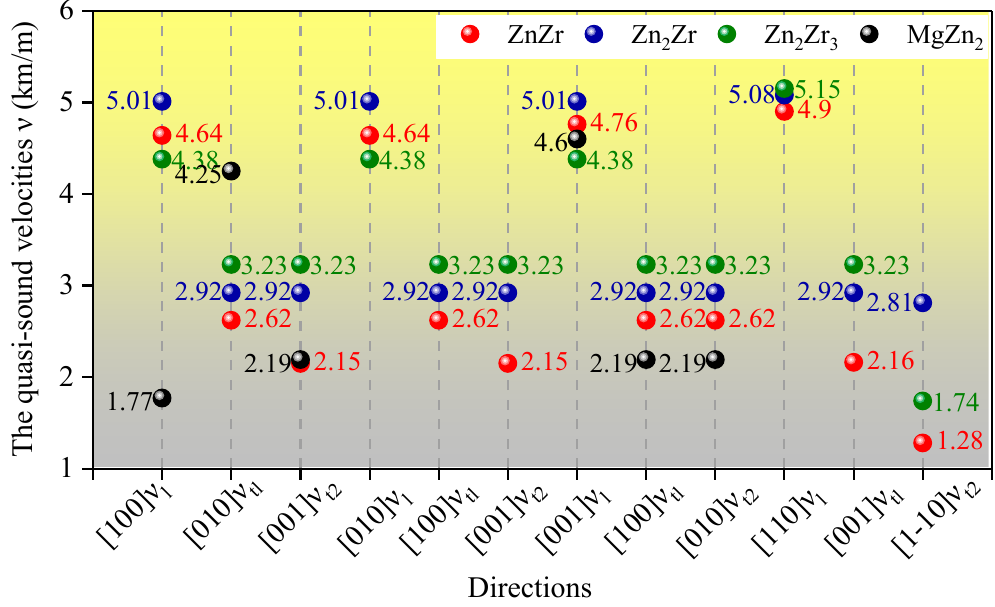
Figure 4. The calculated transverse and longitudinal acoustic velocities along different directions for ZnZr, Zn 2 Zr, Zn 2 Zr 3 , and MgZn 2 .